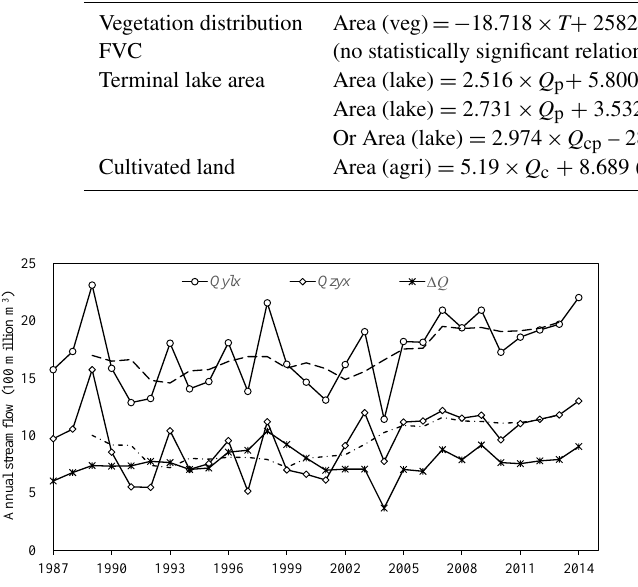
Figure 3. Temporal variations of streamflow at YLX (circle) and ZYX (star) and the difference between the two (cross). The 5-year moving average annual discharge for YLX (dash) and ZYX (dash- dot) are presented to show changing